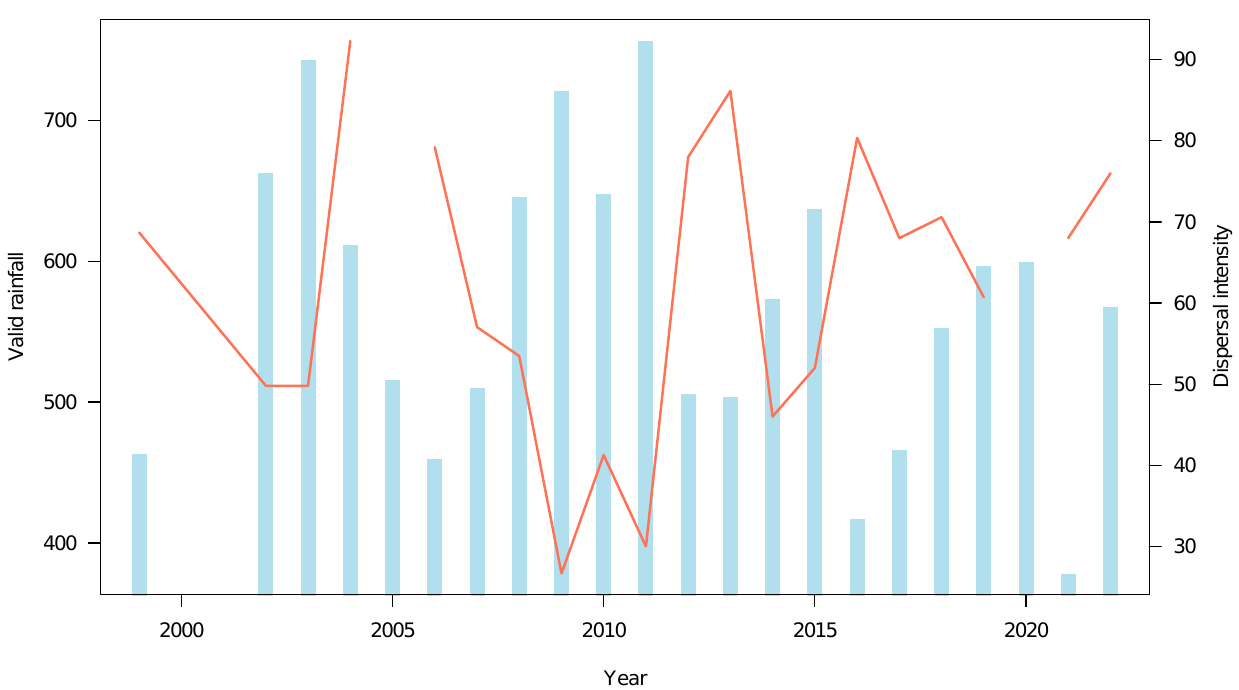
Figure 6. The relation of dispersal intensity of the dead horse arum (red line, right y -axis) and valid rainfall (blue bars, left y -axis) from 1999 to 2022 in high-density area (H.D.) of Aire Island.